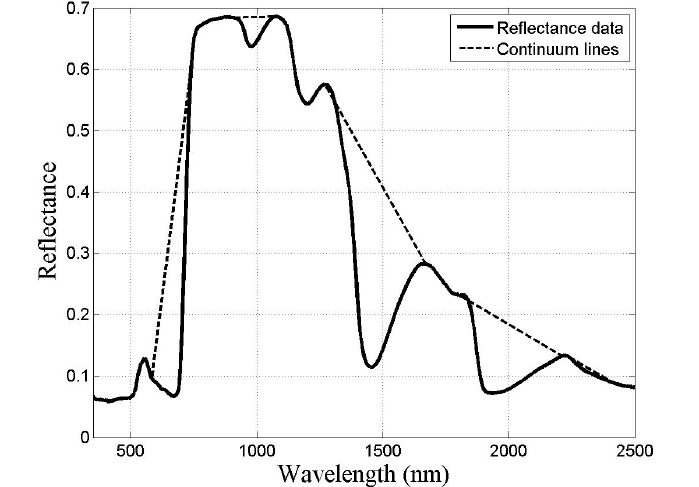
Figure 3. Original reflectance spectrum and continuum lines for healthy black